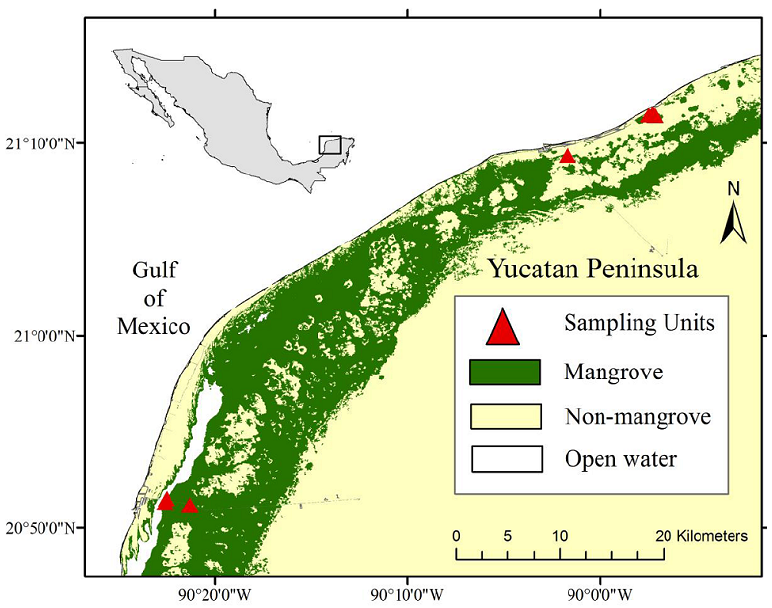
Figure 1. Location of sampling units in the mangrove forest in the north west of Yucatan